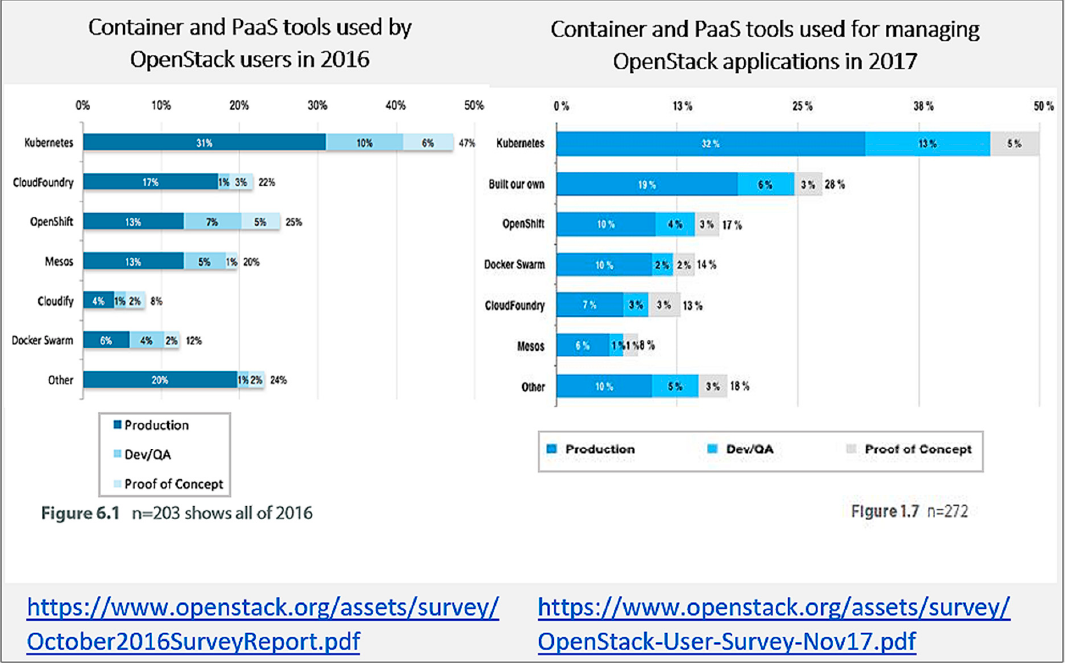
Figure 4. The two most recent annual OpenStack public user surveys show that Kubernetes, OpenShift, Docker Swarm and Mesos are the most popular container orchestration frameworks in OpenStack deployments. Cloud Foundry has decreased in